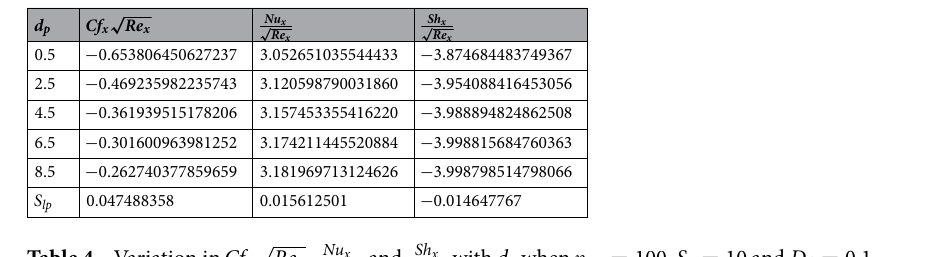
Table 4. Variation in Cf x √ Re x , Nu x